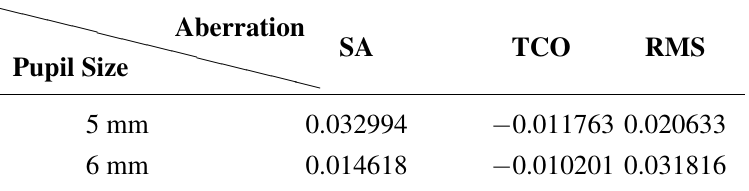
Figure 11. The 2D diagram after applying the GA optimization method. ( a ) 5 mm; ( b ) 6 mm. Table 9. Third-order aberrations after applying the GA optimization method.